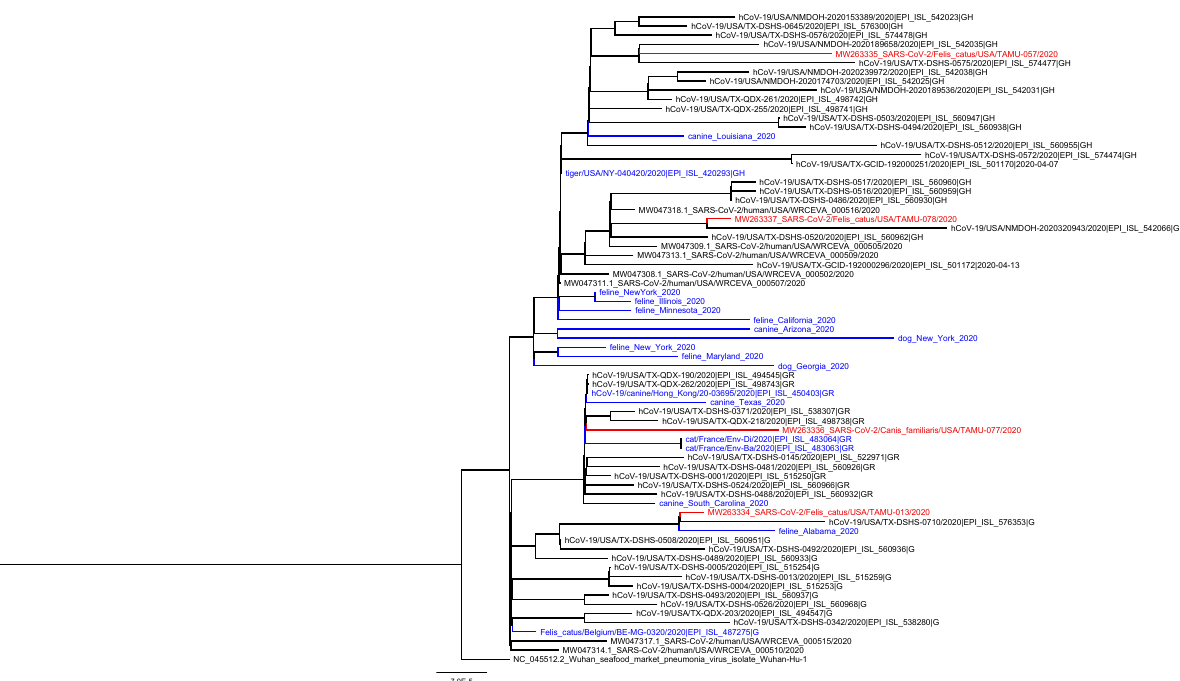
Figure 1. Phylogenetic analysis of SARS-CoV-2 whole genome sequences obtained from this study. These include three cats and one dog (red; animal ID: TAMU-013, 057, 077, 078) and SARS-CoV-2 genomes from feline and canine hosts based on prior studies (blue) and from humans from Texas (black). The analysis used RAxML with the GTRCAT model [23].